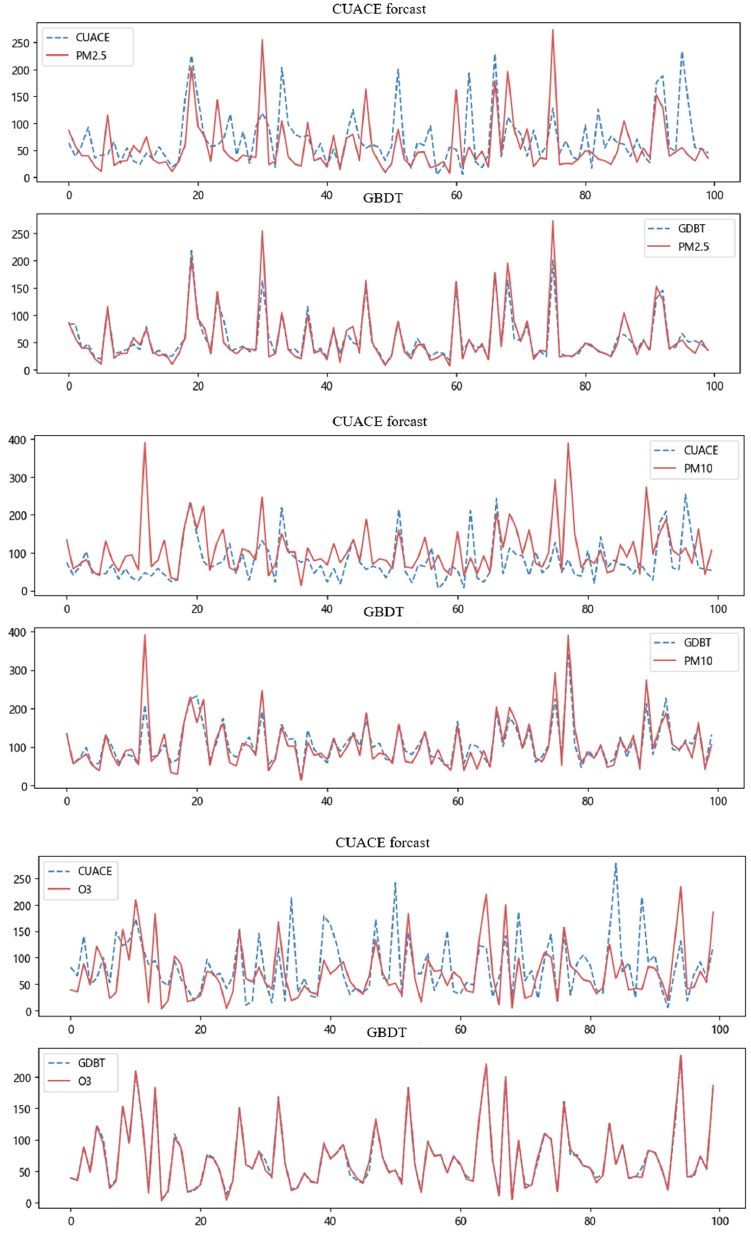
Figure 7. GBDT algorithm correction results. The XGB algorithm for di ff erent air pollution correction e ff ects is shown in Figure 8.